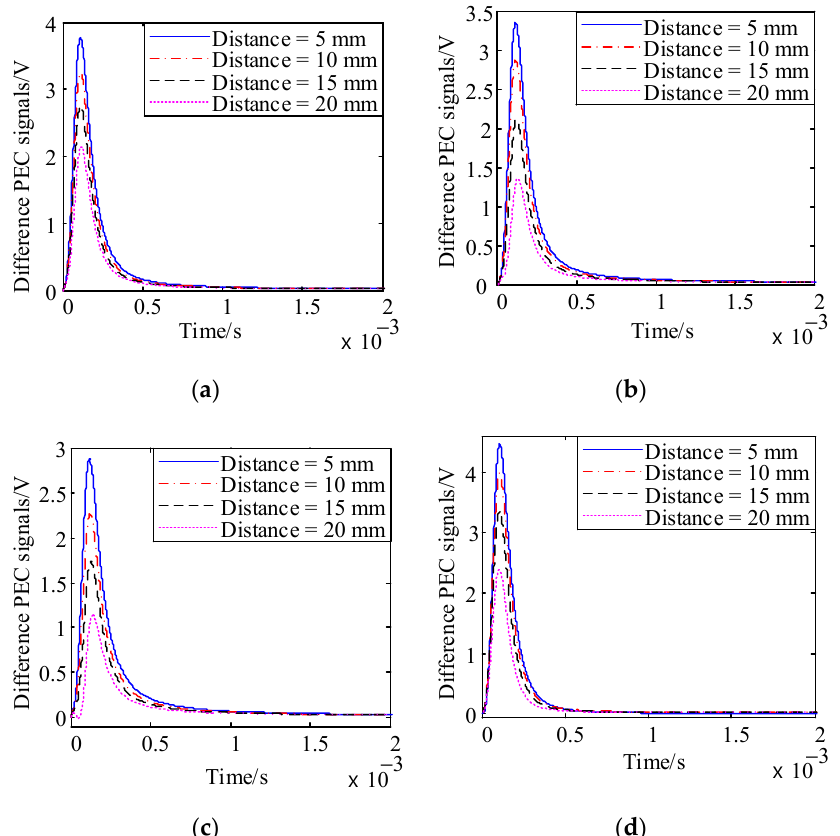
Figure 16. The difference PEC signals. ( a ) A3 steel; ( b ) 45# steel; ( c ) 65Mn steel; ( d ) nodular cast iron.